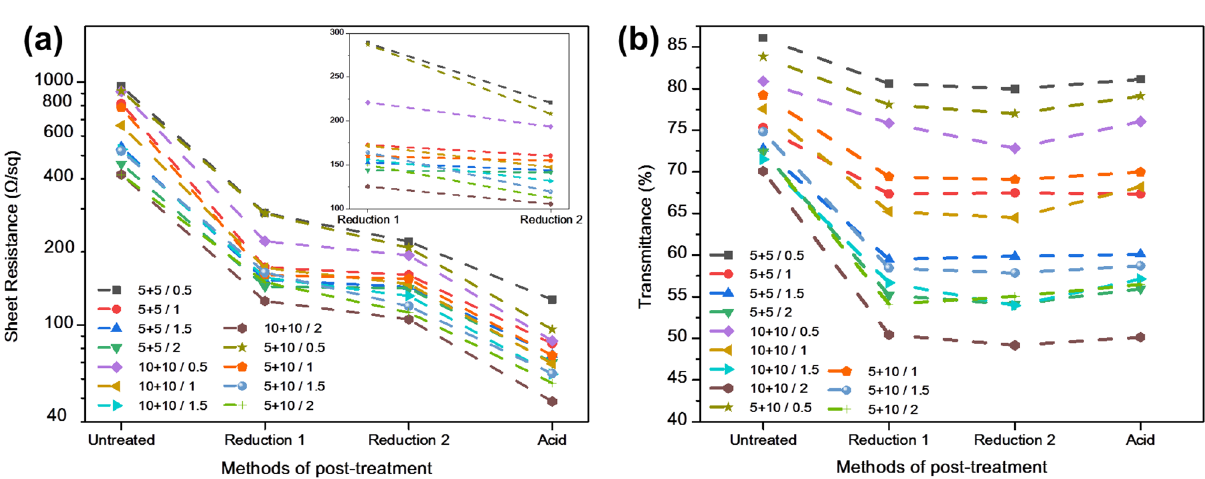
Figure 5. Change in ( a ) sheet resistance and ( b ) transmittance with different RGO-CNT films consisting of different GO/CNT ratios and experiencing different processing times and processing